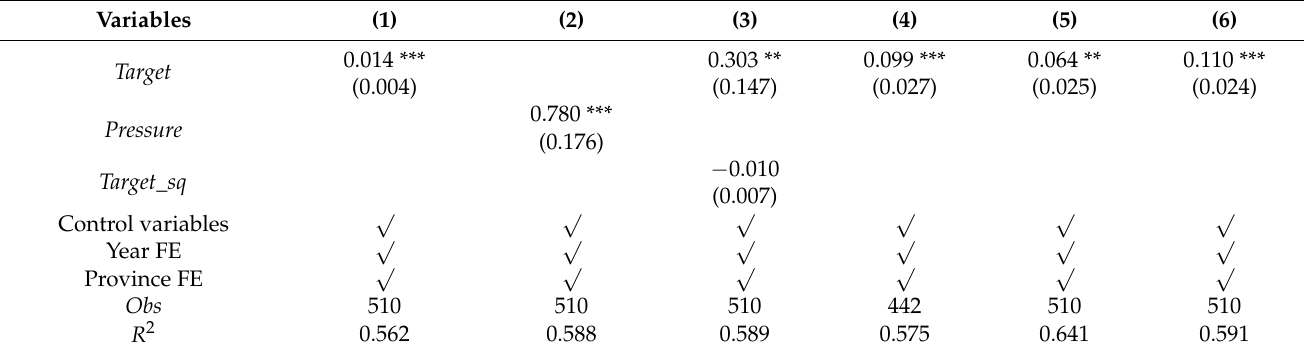
Table 3. Robustness